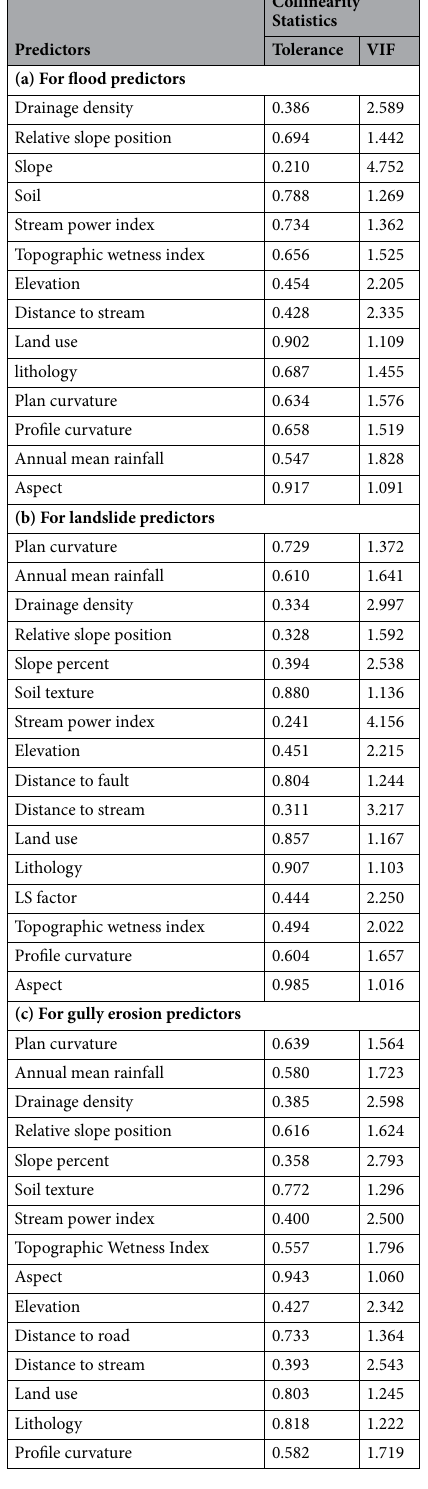
Table 3. The results of multi-collinearity